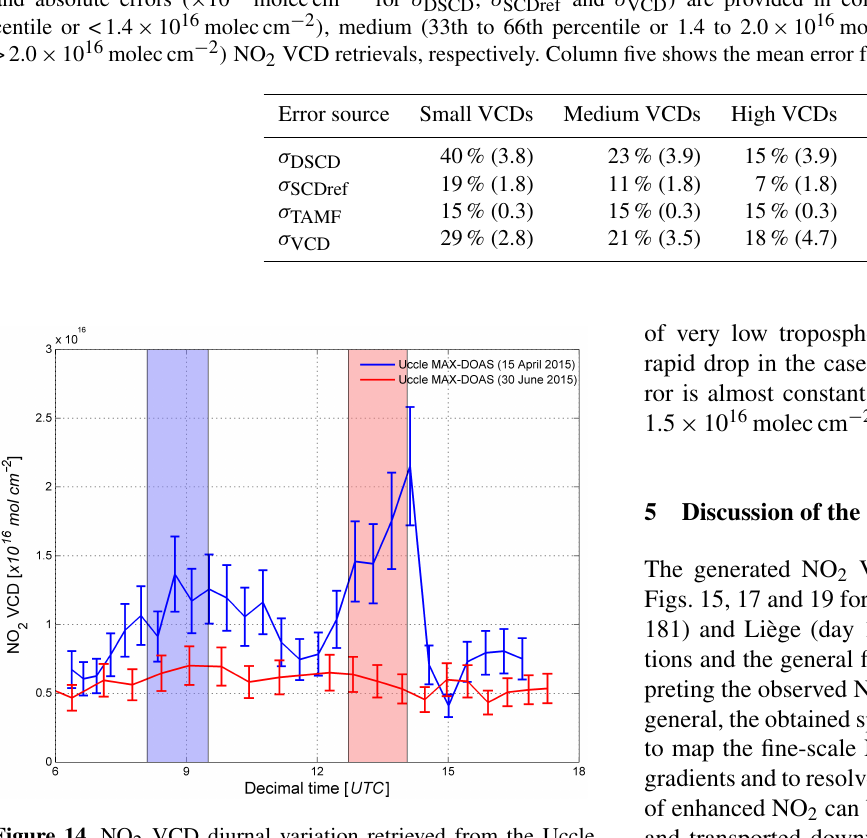
Table 7. Error budget analysis based on 73000 retrieved NO 2 VCDs of the Antwerp data set. Typical relative errors (percent) and absolute errors ( × 10 15 moleccm − 2 for σ DSCD , σ SCDref and σ VCD ) are provided in column two to four, for small (<33th per- centile or <1.4 × 10 16 moleccm − 2 ) , medium (33th to 66th percentile or 1.4 to 2.0 × 10 16 moleccm − 2 ) and high (>66th percentile or